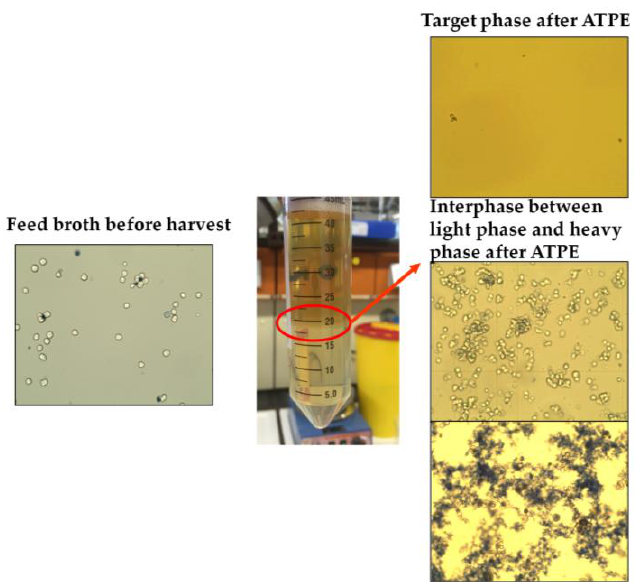
Figure 1. Cell clearance through interfacial partitioning. ATPE: Aqueous two-phase extraction.